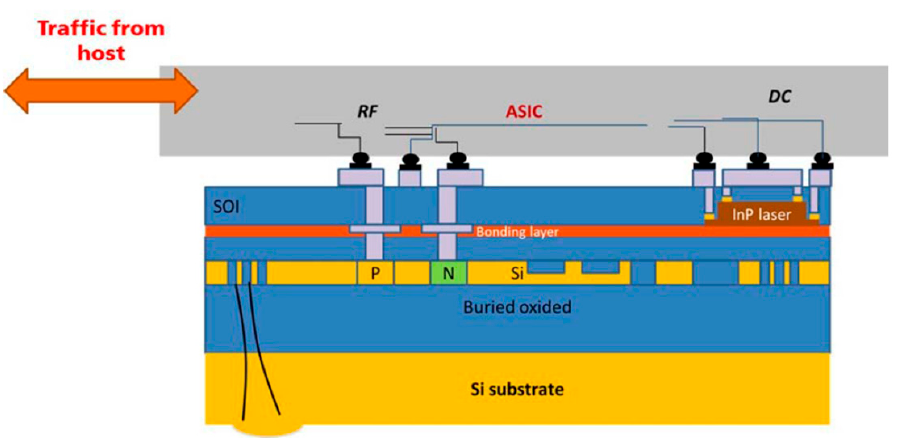
Figure 2. A schematic of the L3MATRIX Approach: Switch and I/O ASICs co-packaged on a common substrate. Inset: Side-view layout of the chiplet assembly with Tx and Rx SiP matrices; the chiplet is assembled facing down through a cutout hole in the substrate.